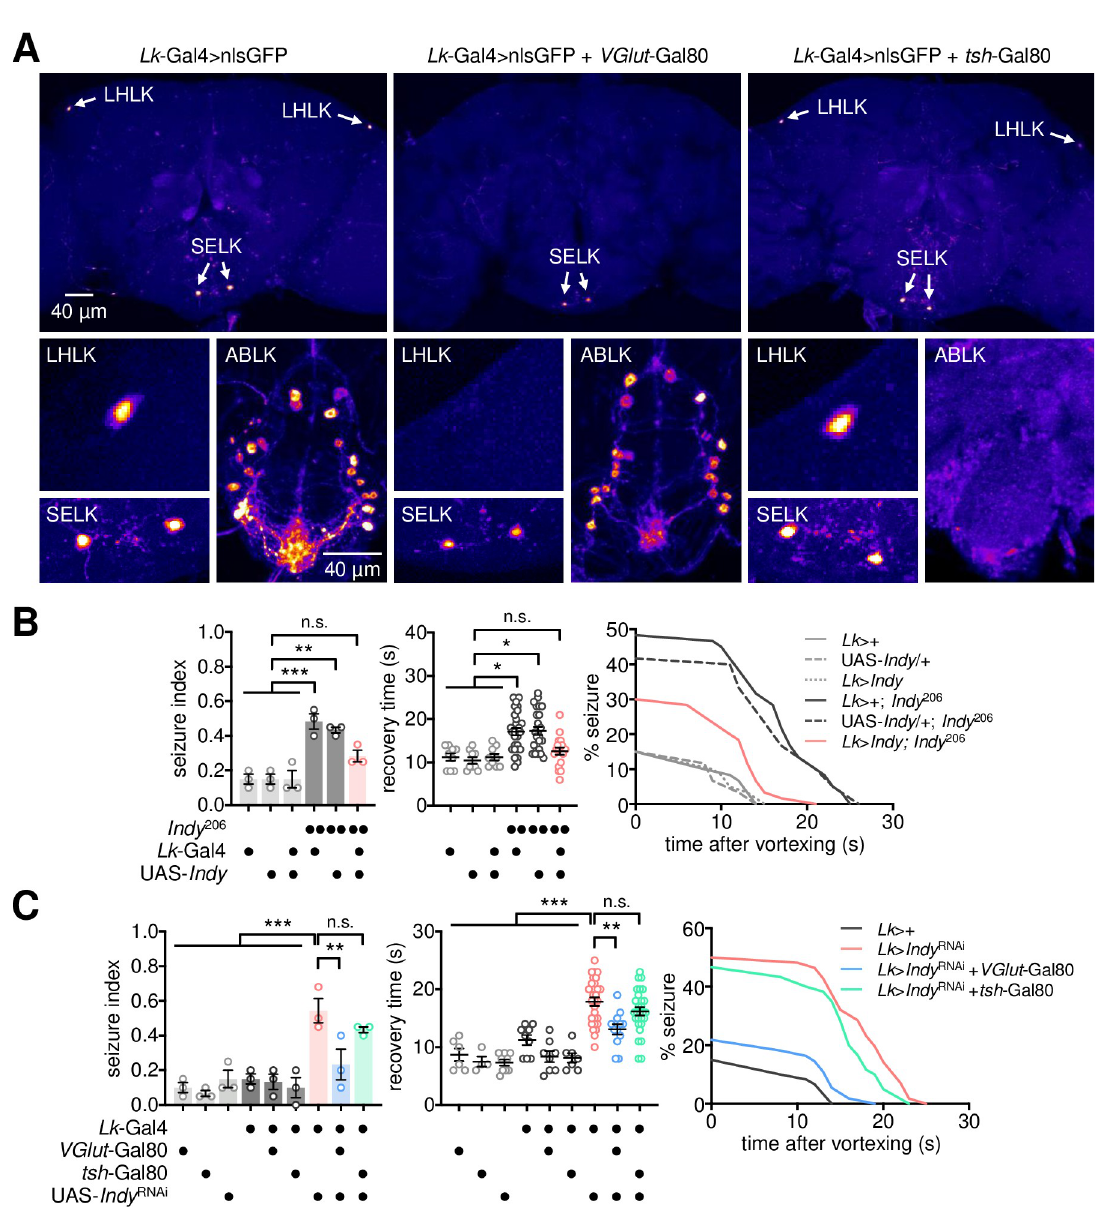
Fig 4. A pair of LK neurons mediates Indy -dependent BSS. (A) A glutamatergic transgene specifically targets a pair of LHLK neurons among LK neurons. LK neurons in the adult brain (LHLK and SELK) and ventral nerve cord (ABLK) were visualized by transgene expression of nuclear GFP (nlsGFP). The VGlut-Gal80 transgene suppressed GFP expression only in LHLK neurons. Representative confocal images of each genotype were shown. (B) INDY overexpression in LK neurons is sufficient to rescue BSS phenotypes in Indy mutants. Quantitative analyses of BSS in individual flies were performed as described in Fig 1. Data represent means ± SEM. n.s., not significant; � P < 0.05, �� P < 0.01, ��� P < 0.001, as determined by two-way ANOVA with Holm-Sidak’s multiple comparisons test (seizure index, n = 60 flies in 3 independent experiments) or by Aligned ranks transformation ANOVA with Wilcoxon rank sum test (recovery time, n = 9–29). (C) INDY depletion in a pair of LHLK neurons is necessary for BSS phenotypes in Indy RNAi flies. LK neuron-specific expression of the Indy RNAi transgene was inhibited specifically in LHLK neurons by the VGlut-Gal80 transgene. Data represent means ± SEM (seizure index, n = 55–60 flies in 3 independent experiments; recovery time, n = 3–28 flies). n.s., not significant; �� P < 0.01, ��� P < 0.001, as determined by one-way ANOVA with Holm-Sidak’s multiple comparisons test.